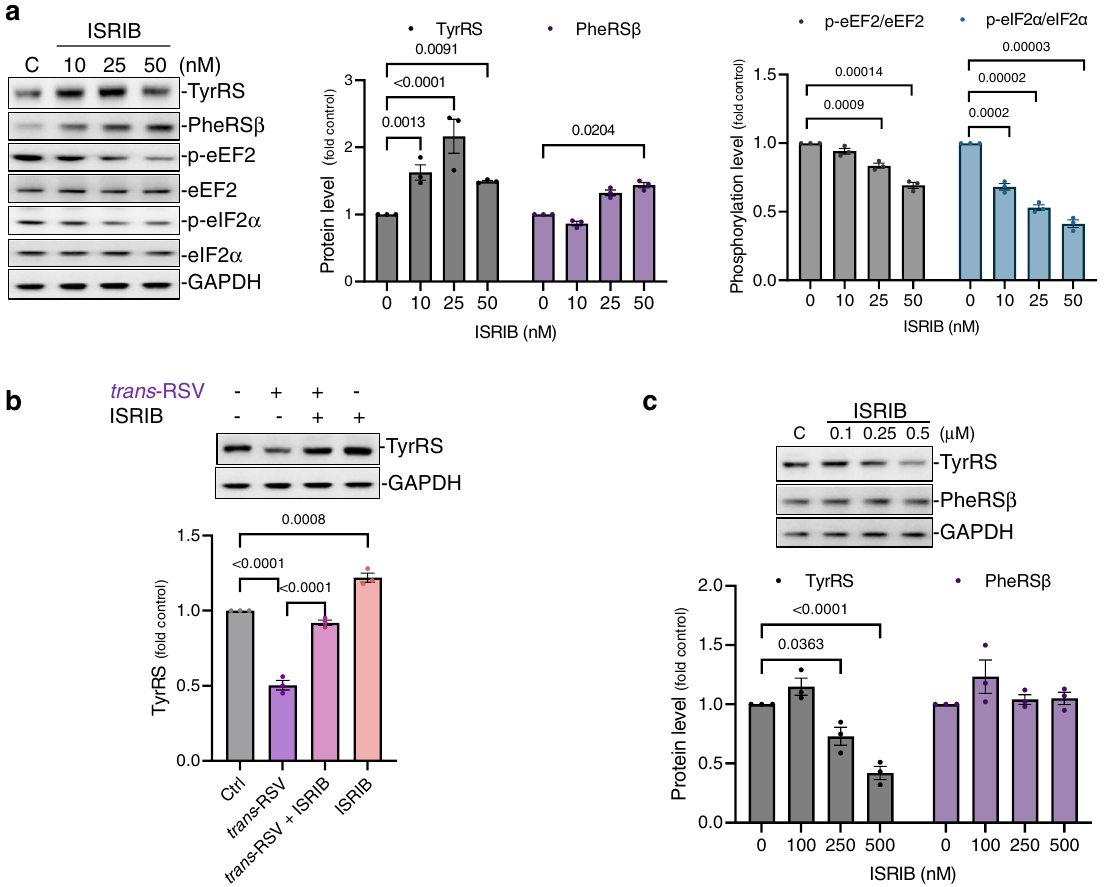
Fig. 5 ISRIB has concentration-dependent dichotomic effects on neuronal TyrRS levels. a Lower doses of ISRIB increase TyrRS protein levels in neurons . Primary cortical neurons were treated with ISRIB ( ≤ 50 nM) for 8 hr and changes in the levels of TyrRS, PheRS β , p-eEF2, eEF2, p-eIF2 α , and eIF2 α were detected and quanti fi ed by WB analysis using their respective antibodies. b Low dose ISRIB protects neurons against trans-RSV-mediated depletion of TyrRS . Primary cortical neurons were treated with trans -RSV (25 μ M) alone or in combination with ISRIB (10 nM) for 8 hr, and changes in the levels of TyrRS were detected by WB. c High concentrations of ISRIB decrease TyrRS protein levels in cortical neurons . Primary rat cortical neurons were treated with ISRIB (100 – 500 nM) for 8 hr and changes in the levels of TyrRS, and PheRS β were detected by WB analysis using their respective antibodies. All data represent mean ± SEM for n = 3 independent experiments with signi fi cance measured using two-way ANOVA with Dunnett ’ s test for multiple cis -RSV decreased the levels of caspase-3 cleavage (Supplemen- tary Fig. 9d). However, treatment with either ISRIB, eEF2K inhibitor, or DA protected against neurotoxic effects of trans -RSV (Supplementary Fig. 9f – h), indicating a critical role of sustained protein synthesis in neuronal DNA repair and survival.